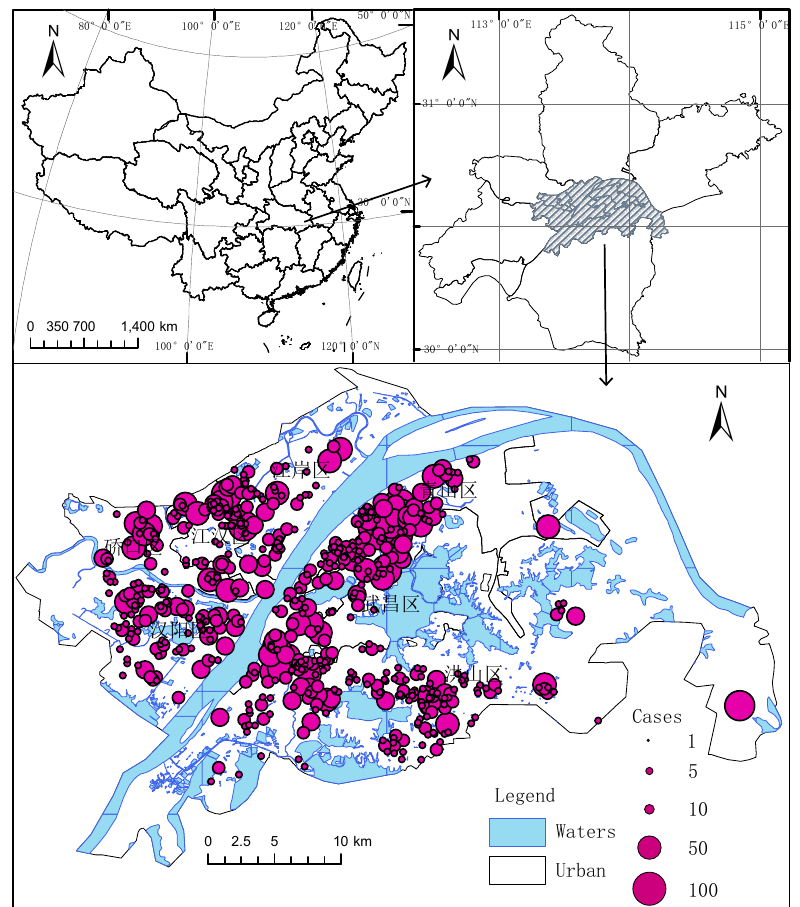
Figure 2. Study area infection